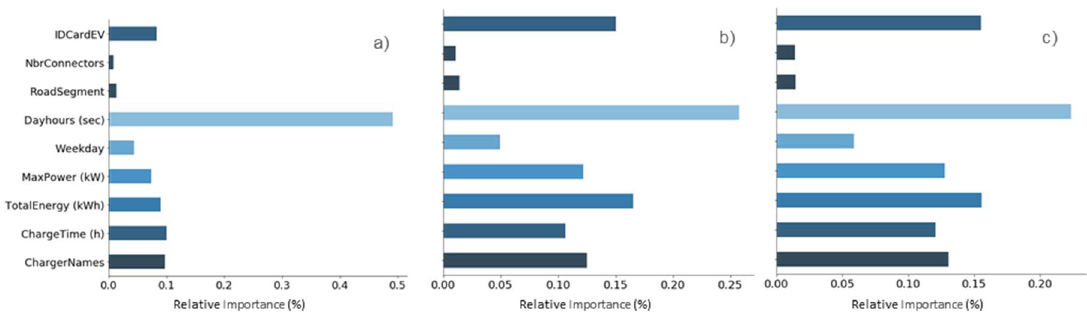
Figure 5. Feature Importance by method ( a ) Random Forest, ( b ) Gradient Boosting Machine, ( c ) c ) XGBoost. (